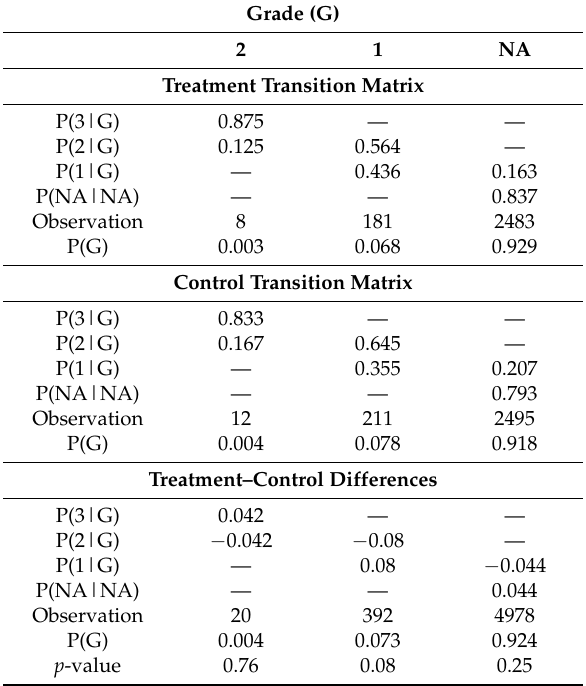
Table 4. Transition matrices (ages 5–6).